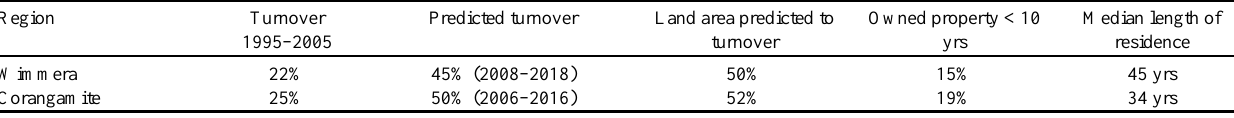
Table 1 . Property turnover trends: Corangamite and Wimmera natural resource management